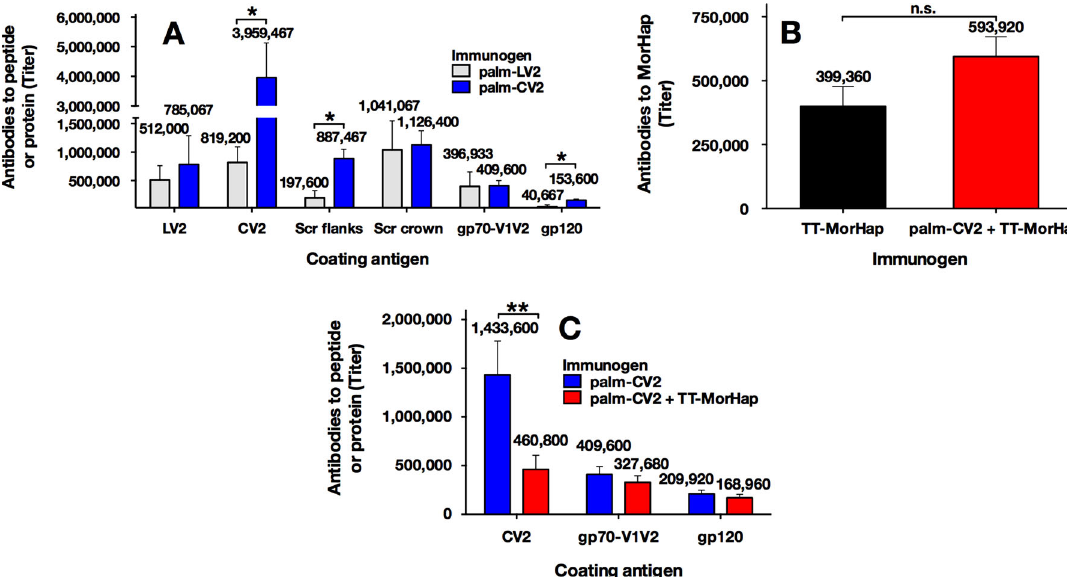
Fig. 4 Serum IgG antibodies speci fi c to peptides and MorHap. a Mice (six per formulation) were immunized with palm-LV2 or palm-CV2 and bled at week 9 and assayed for antibodies to LV2, CV2, scrambled (Scr) fl anks, Scr crown, gp70-V1V2 and gp120. b Mice (ten per formulation) were immunized with TT-MorHap or palm-CV2+TT-MorHap, bled at week 8, and assayed for antibodies to MorHap. c Mice (ten per formulation) were immunized with palm-CV2 or palm-CV2+TT-MorHap, bled at week 8, and assayed for antibodies to CV2, gp70-V1V2, or gp120. Individual serum samples were analyzed by ELISA. Values are mean endpoint titers ± SEM. Asterisks indicate signi fi cant difference between the two vaccine formulations using a Mann – Whitney t test (* p < 0.05; ** p <